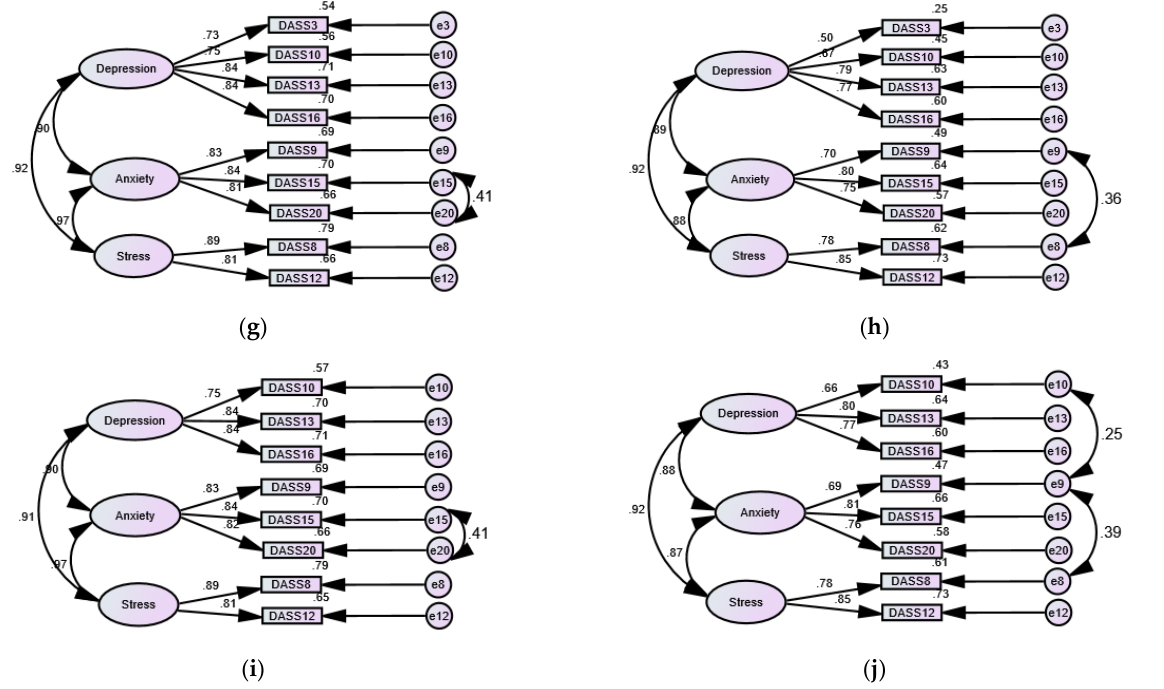
Figure 1. Three-factor structures of shortened versions of the Depression Anxiety stress scale 21 (DASS-21) in patients with psychiatric disorders and in the general public, in order: the DASS-12 ( a , b ), the DASS-13 ( c , d ), Osman’s DASS-9 ( e , f ), a modified DASS-9 ( g , h ), and DASS-8 ( i , j ).